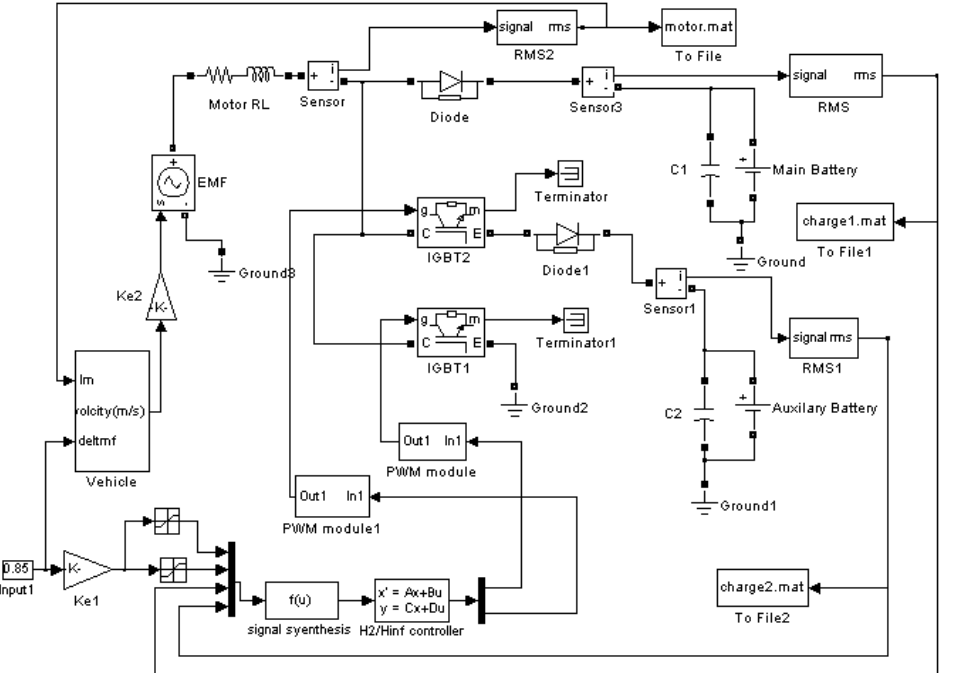
Figure 6. The simulation model of the proposed energy recovery system.